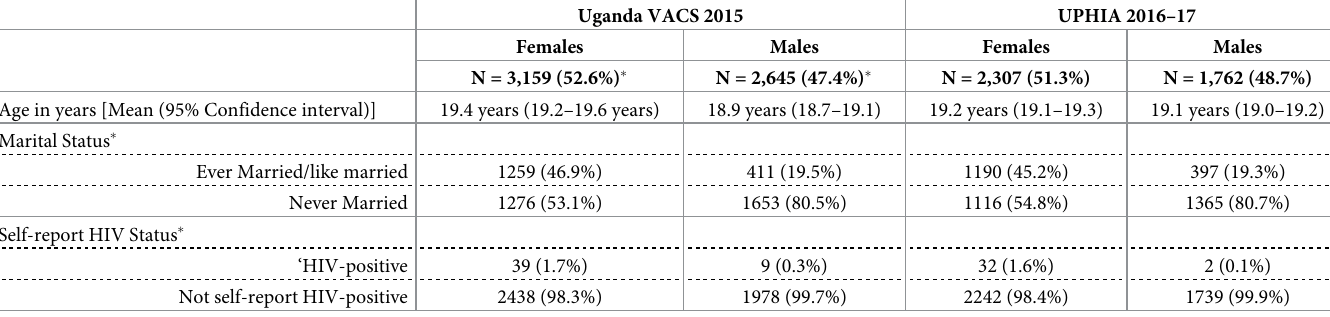
Table 3. Weighted demographic characteristics and self-reported HIV status of Uganda VACS 2015 and UPHIA 2016–17 participants, by